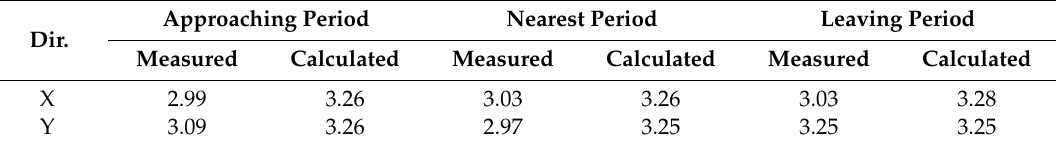
Table 3. Peak factors from measurement and calculation during different periods.